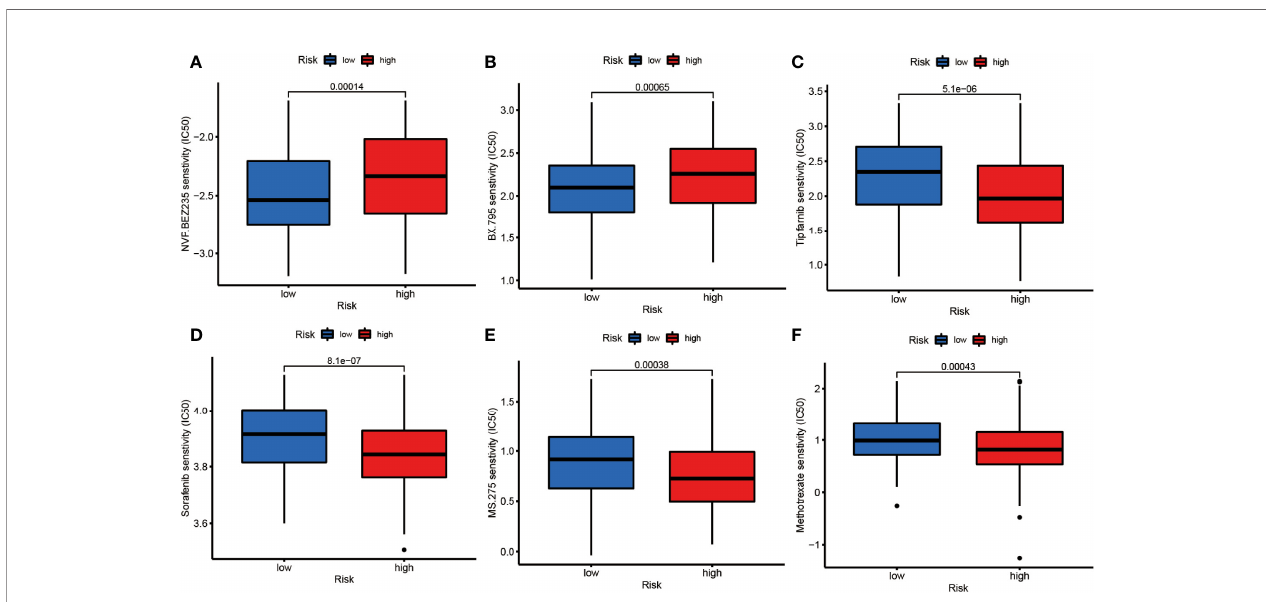
FIGURE 8 | The drug sensitivity of (A) NVP.BEZ235, (B) BX795, (C) Tipifarnib, (D) Sorafenib, (E) MS.275, (F) Methotrexate between the low- and high-risk groups